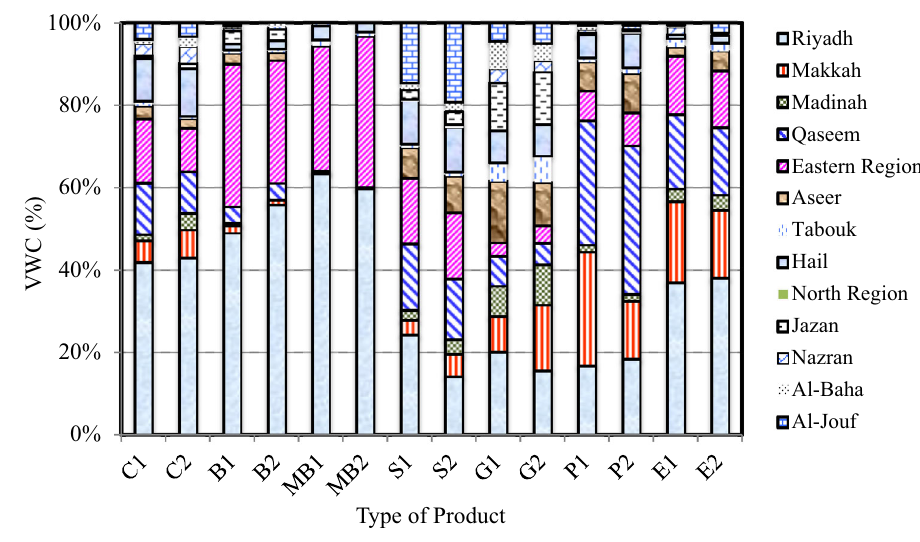
Fig. 4 Regional distribution of VWC for livestock farms in 2006 and 2010 (million m 3